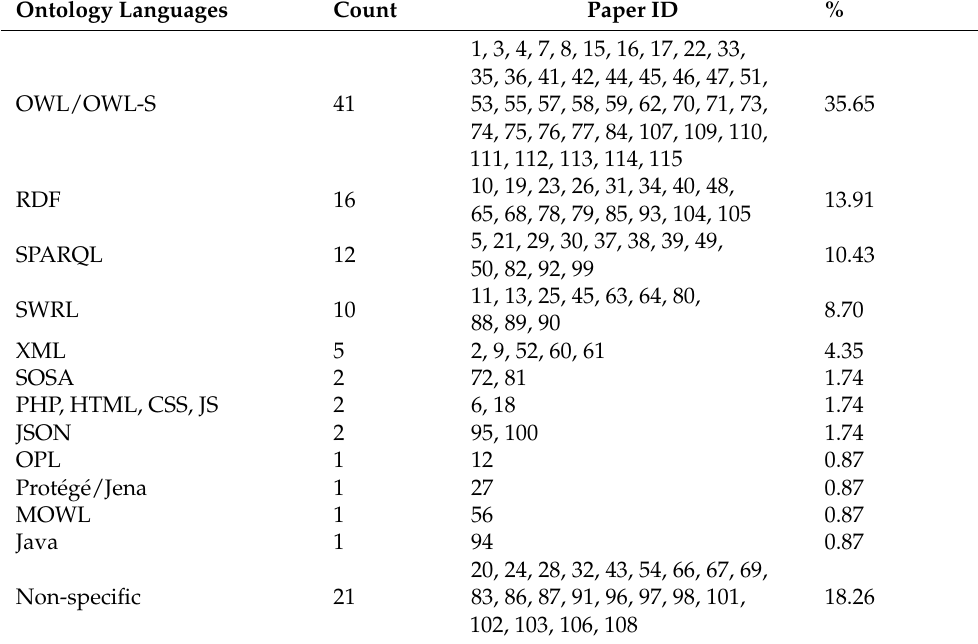
Table 4. Popular Languages of Ontology in